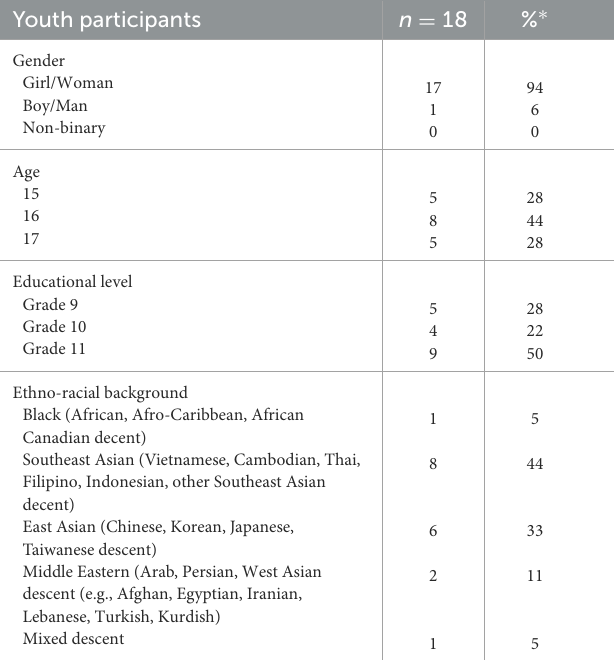
TABLE 2 Demographic characteristics of Agenda Gap youth participants.